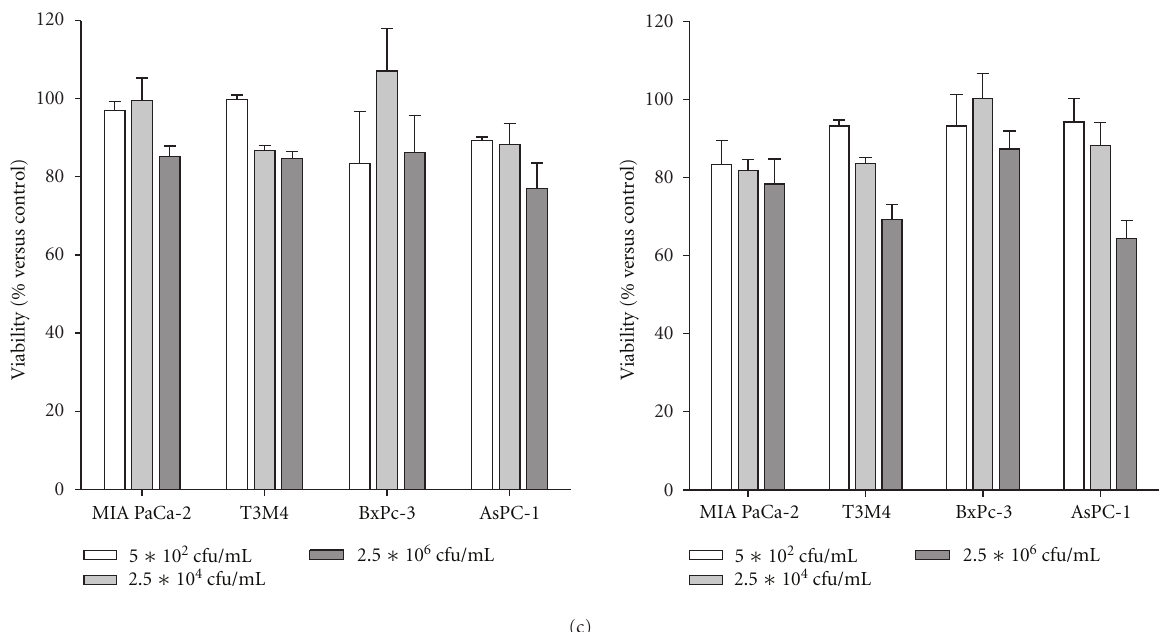
Figure 1: Electron microscopy. (a) Representative pictures showing CT binding to tumor cells via surface molecules (upper panel). Sustained cellular integrity despite heat inactivation was confirmed (lower panel). Cell proliferation and viability. (b) Tumor cells were seeded in 96- well plates and cultured with increasing CT concentrations (corresponding to 5 ∗ 10 2 , 2.5 ∗ 10 4 , and 2.5 ∗ 10 6 cfu/mL) for 24 and 48hours. Thereafter, cell proliferation was estimated by BrdU uptake and quantification on a plate reader at 450nm according to the manufacturer’s instructions. Percentage of proliferating cells was calculated compared to untreated control (100%). (c) For estimating viability, tumor cells were seeded in 24-well plates and treated with CT as described above. Following the incubation period (24 and 48hours), the cells were stained with Calcein AM and fluorescence intensity was measured on a plate reader (ex/em 485/535 nm). Cell viability was calculated by setting relative fluorescence intensities of Calcein AM-stained nontreated cells (live control) to 100%. Results show data of three separate experiments each performed in duplicates. Values are given as the mean ±